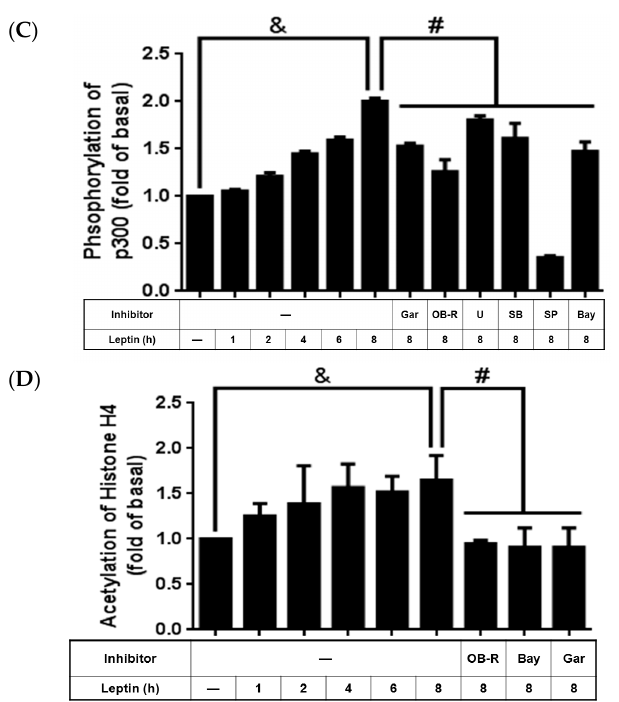
Figure 6. Effects of garcinol and p300 siRNA on leptin-stimulated A549 cells. Serum-starved A549 cells were pretreated with the OB-R antibody (2 µg/mL), U0126 (10 µM), SB202190 (10 µM),